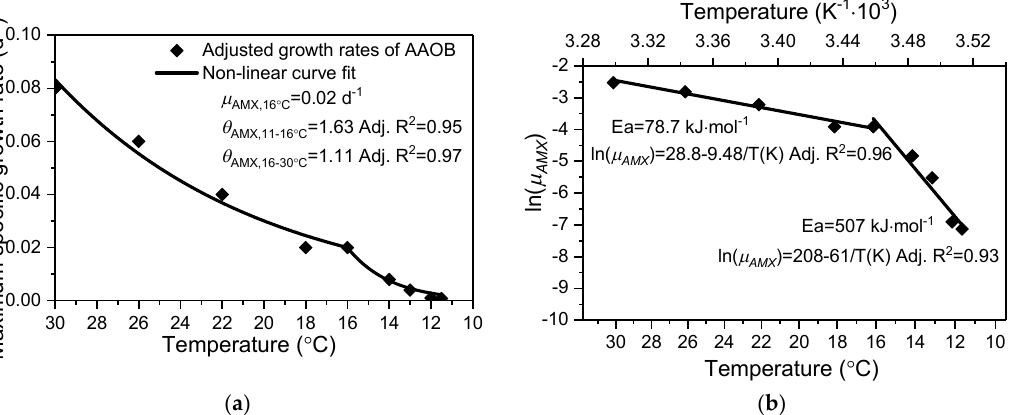
Figure 4. The temperature effects on the specific anammox growth rates in the studied SBR described by the Arrhenius equations in two temperature ranges ( a ), and estimation of the activation energy ( (cid:1831) (cid:3028) ) in the two temperature ranges ( b ). The (cid:1831) (cid:3028) values could vary from 6 to 437 kJ/mol in terms of different temperature ranges, different reactor configurations, different genera of anammox and under different operational conditions [11,10,15,43,44,45]. In general, lower (cid:1831) (cid:3028) values were found at higher investigated temperature ranges, i.e., 6–239 kJ/mol for T = 15–40 °C vs. 93–437 kJ/mol for T = 6–28 °C. In the present study, the (cid:1831) (cid:3028) values, estimated for the lower tem- perature range, were slightly higher than the reported values. This may indicate higher temperature sensitivity and the difficulty of achieving efficient nitrogen removal under low temperatures. 3.2.3. Temperature Effects on the N Conversion Pathways N conversion pathways were investigated with the validated model at decreasing temperatures (Figure 4a). When the temperature decreased from 30 to 11 °C, the system managed to recover efficient and stable deammonification performance twice when three failures were encountered, as described below. The first failure occurred on day 11. When the temperature dropped from 30 to 22 °C, the first decrease in the NH 4 -N removal efficiency (<60%) was mainly attributed to the sharp decrease in the anammox activity (Figure 4a). Prolonging the non-aerated phase duration (R value from 2 to 4) and reducing the influent NH 4 -N loading (from 790 to 590 mg N/(L·d)) could protect AAOB from the inhibitory effects of DO and FA (threshold of 1.7 mg N/L, Figure 3) and effectively recover the NH 4 -N removal efficiency back to 90%. The first recovery occurred on day 15 at a moderate temperature (22 °C). NH 4 -N con- version and nitrogen removal were mainly attributed to AOB and anammox activities, respectively (Figure 5b). A substantial amount of N 2 O was produced in comparison with the removed nitrogen load, which was mainly attributed to the autotrophic denitrification (AD) pathway mediated by AOB. NO 2 -N accumulation was affected by the balance be- tween NO 2 -N production by AOB and NO 2 -N consumption by AD (63%), AAOB (27%) and NOB (10%), whereas heterotrophic denitrification played a negligible role at decreas- ing temperatures. NO 3 -N accumulation in the system was attributed to the NOB activity (70%) during the aerated phase and AAOB (30%) during the non-aerated phase.